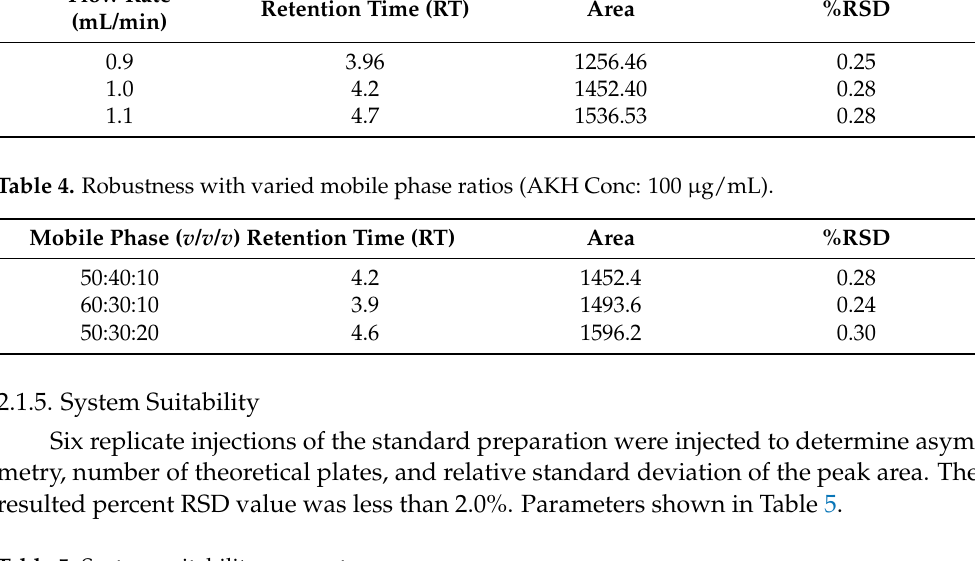
Table 5. System suitability